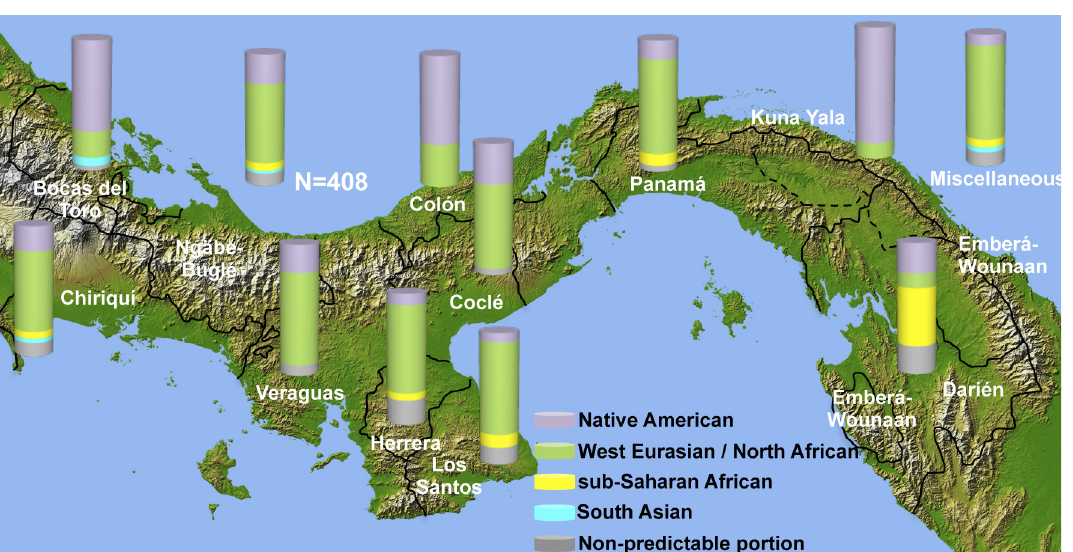
Samples with discordant haplogroup predictions (assigned to different haplogroups or to haplogroup sub- lineages that have discordant phylogeography). f Samples with PGF birthplace in Panama.